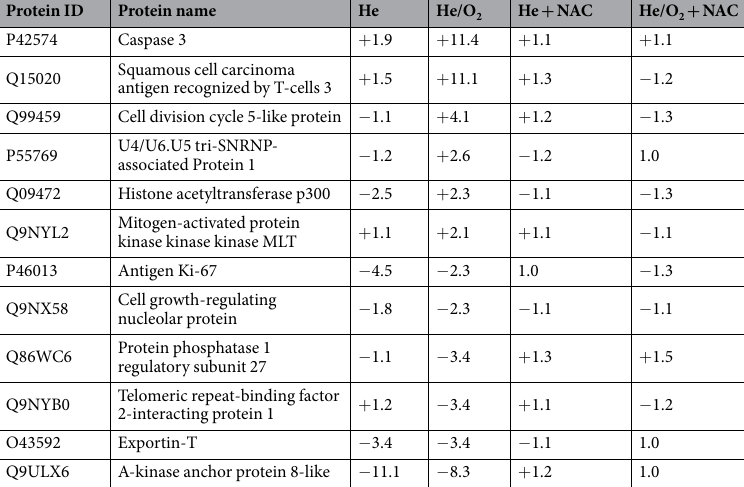
( + 11.1-fold) of this protein was also determined in the cellular fraction using mass spectrometry. Other proteins involved in apoptosis, transport or cell growth were also strongly regulated, for example, A-kinase anchor protein 8-like, Exportin-T, Telomeric repeat-binding factor 2-interacting protein, Cell and growth-regulating nucleolar protein (LYAR), and U4/U6.U5 tri-SNRNP -associated protein 1. A pro-immunogenic protein (Squamous cell carcinoma antigen recognized by T-cells 3) was increased as well.